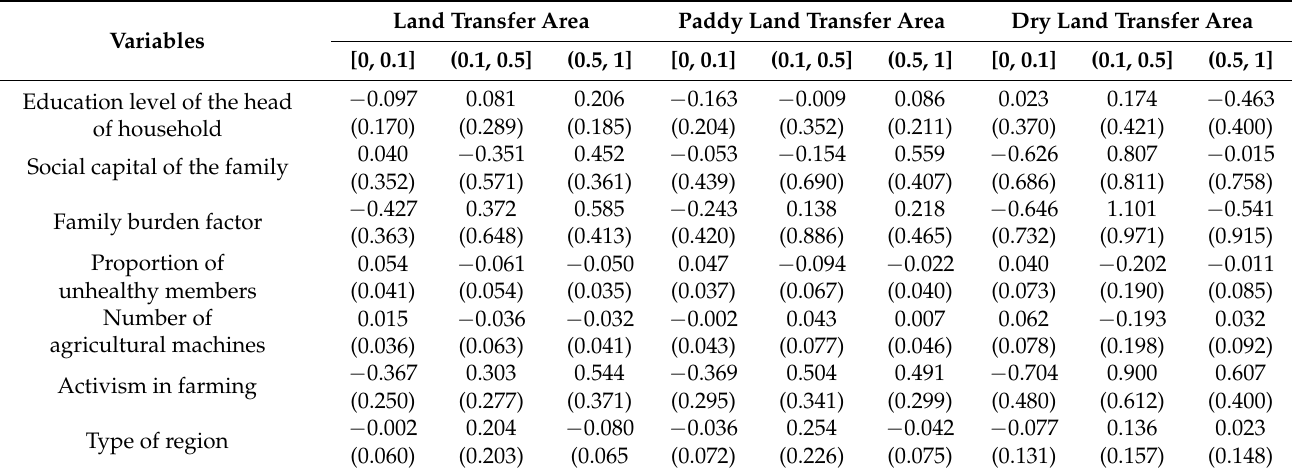
Table 4. Generalized propensity score matching balance test for the proportion of non-farm employ- ment personnel in farm households.